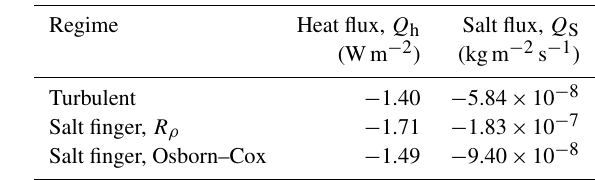
Table 1. Heat and salt flux estimates calculated using diffusivities in the turbulent and salt-finger regime. Fluxes for the latter regime are estimated from R ρ using the empirical relations of Radko and Smith (2012) and from χ using the Osborn–Cox relation (Osborn and Cox, 1972). All flux estimates have been averaged (arithmetic mean) between 200 and